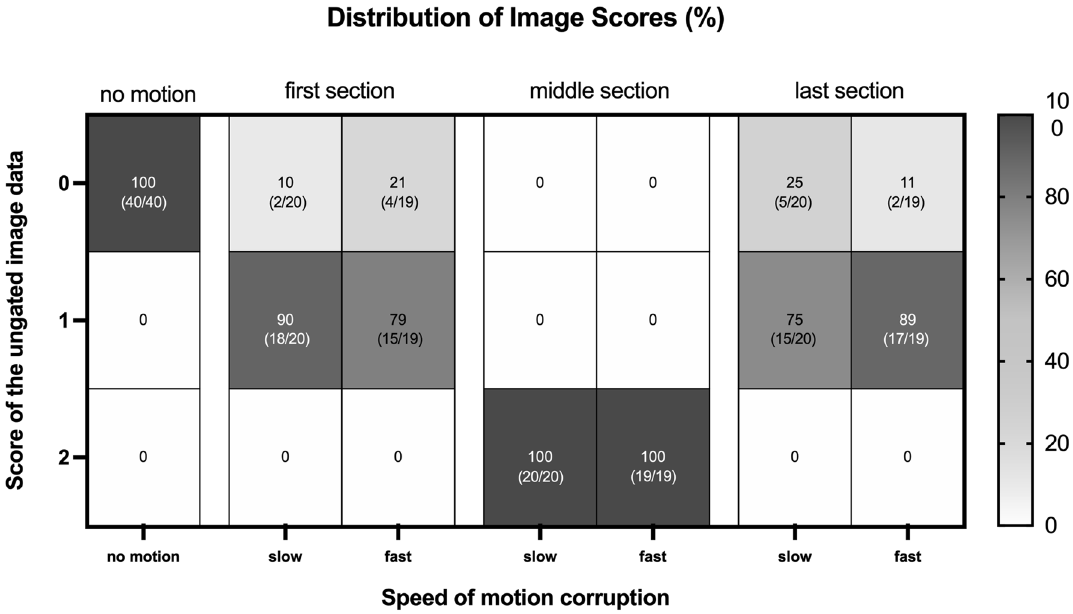
Figure 4. Image scores of scans with motion corruption in each section. Displayed is the absolute and relative number (%) of ungated images rated with a score of zero, one or two sorted by the timepoint (section) and the speed of the corrupting motion. On the righthand side a scale bar shows the matching colour for the referring values in percent. All images without motion were labelled with a score of zero (100%) whereas all images containing motion corruption in the middle section received a score of two (100%). Images with motion in the first or last section were mostly rated with a score of one. None of the images in the first or last section of the scan was rated with a score of two.